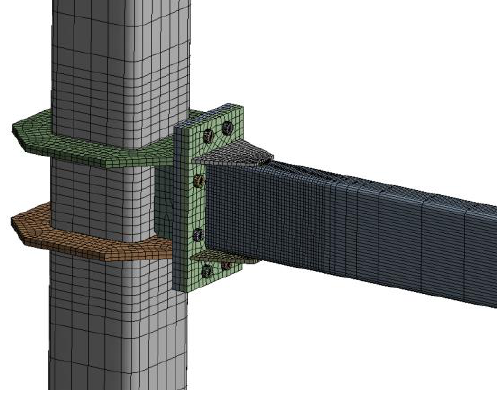
Figure 10. Mesh used in numerical model.